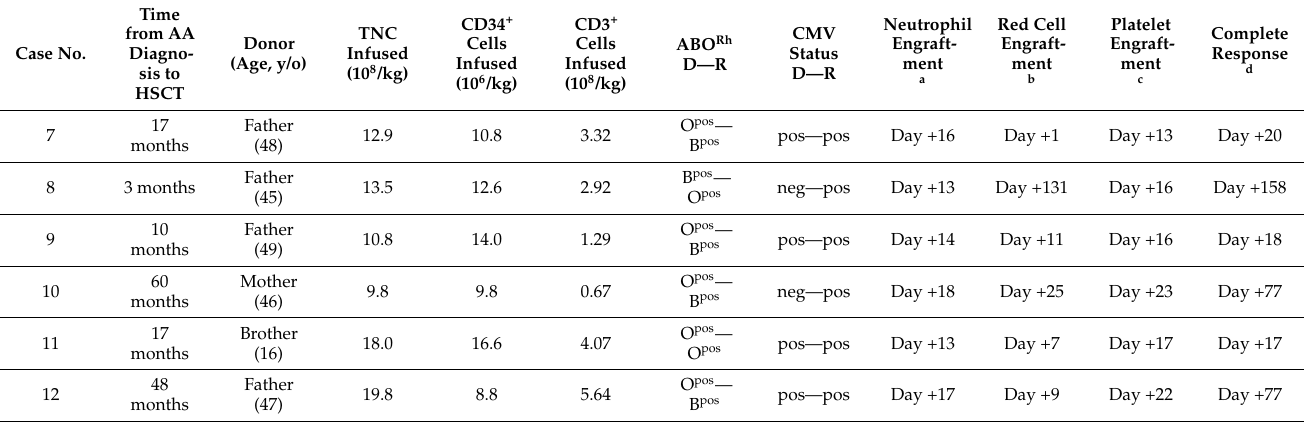
Table 3. Characteristics of haploidentical PBSCT.